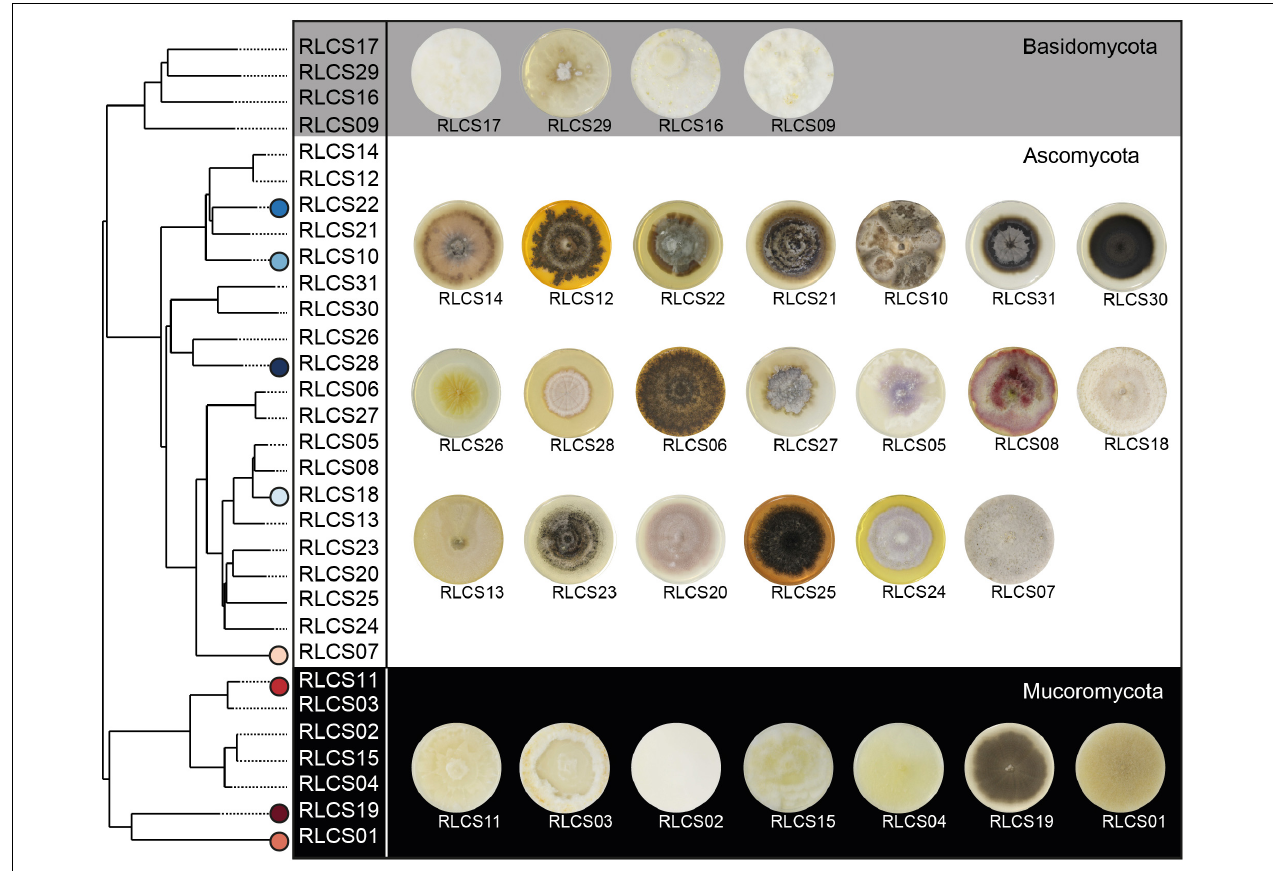
FIGURE 1 | Overview of fungal strains. Phylogenetic tree (maximum clade-credibility tree) of the 31 saprobic fungal strains comprising members of the phyla Ascomycota, Basidiomycota, and Mucoromycota. Following the order of the tree, images of 4 week old colonies grown on PDA are assigned to the tree. Further information about phylogeny and accession numbers of the 31 fungal strains are available in Supplementary Table S2 . Strains performing best and poorest are marked; blue symbols represent good and red symbols poor